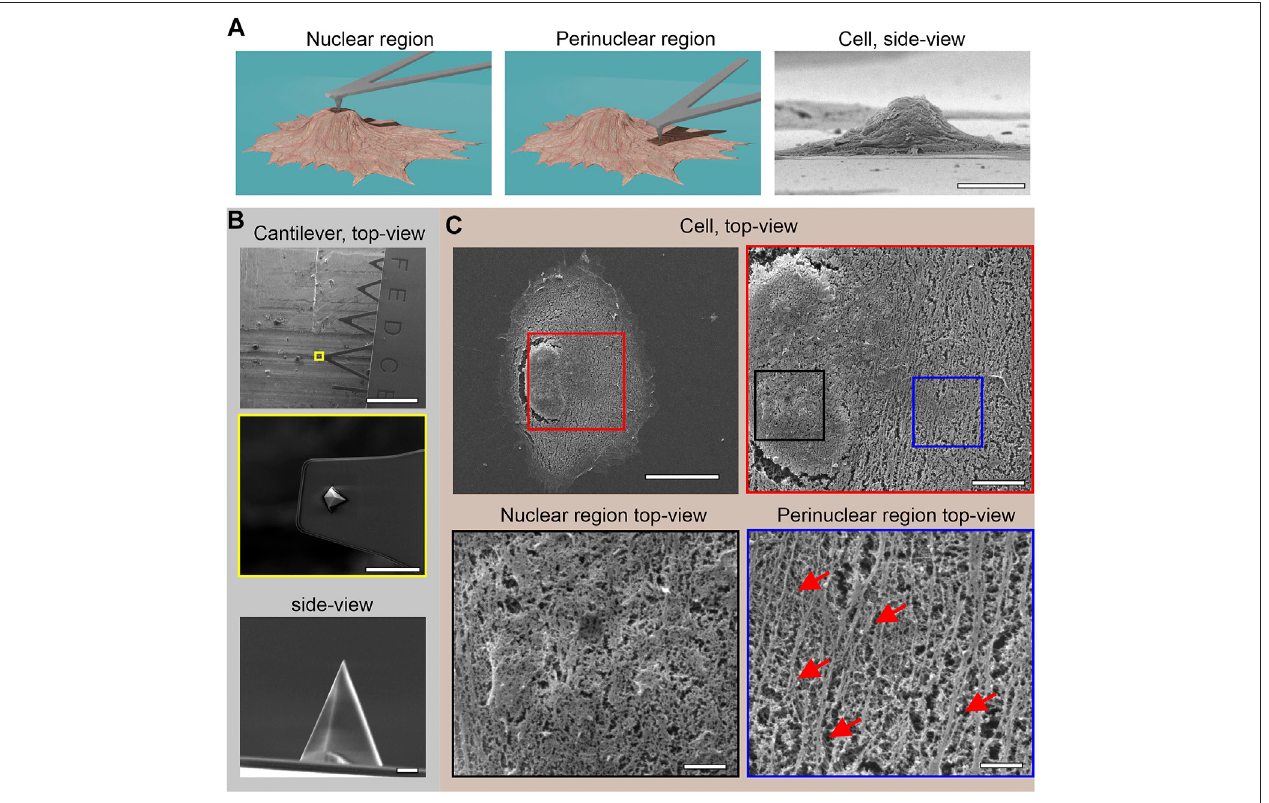
FIGURE 1 | Scanning electron microscopy images. (A) Schemes of AFM cantilever positioning at the nuclear (left) and perinuclear (middle) cell regions, showing also aside-view ofahTERT-RPE1 cell after membrane removal (right) . (B) Representative images ofthe AFM cantilever (top) and theindenter (middle,bottom) . (C) A representative hTERT-RPE1 cell after membrane removal at different magni fi cations (color-coded frames highlight the magni fi ed regions). Arrows, exemplary actin bundles. Scale bars: (A) : 10 μ m; (B) top to bottom: 300 μ m, 10 μ m, 1 μ m; (C) : 20 µm (top left) , 5 µm (top right) , 1 µm (bottom left, black frame), 1 µm (bottom right, blue